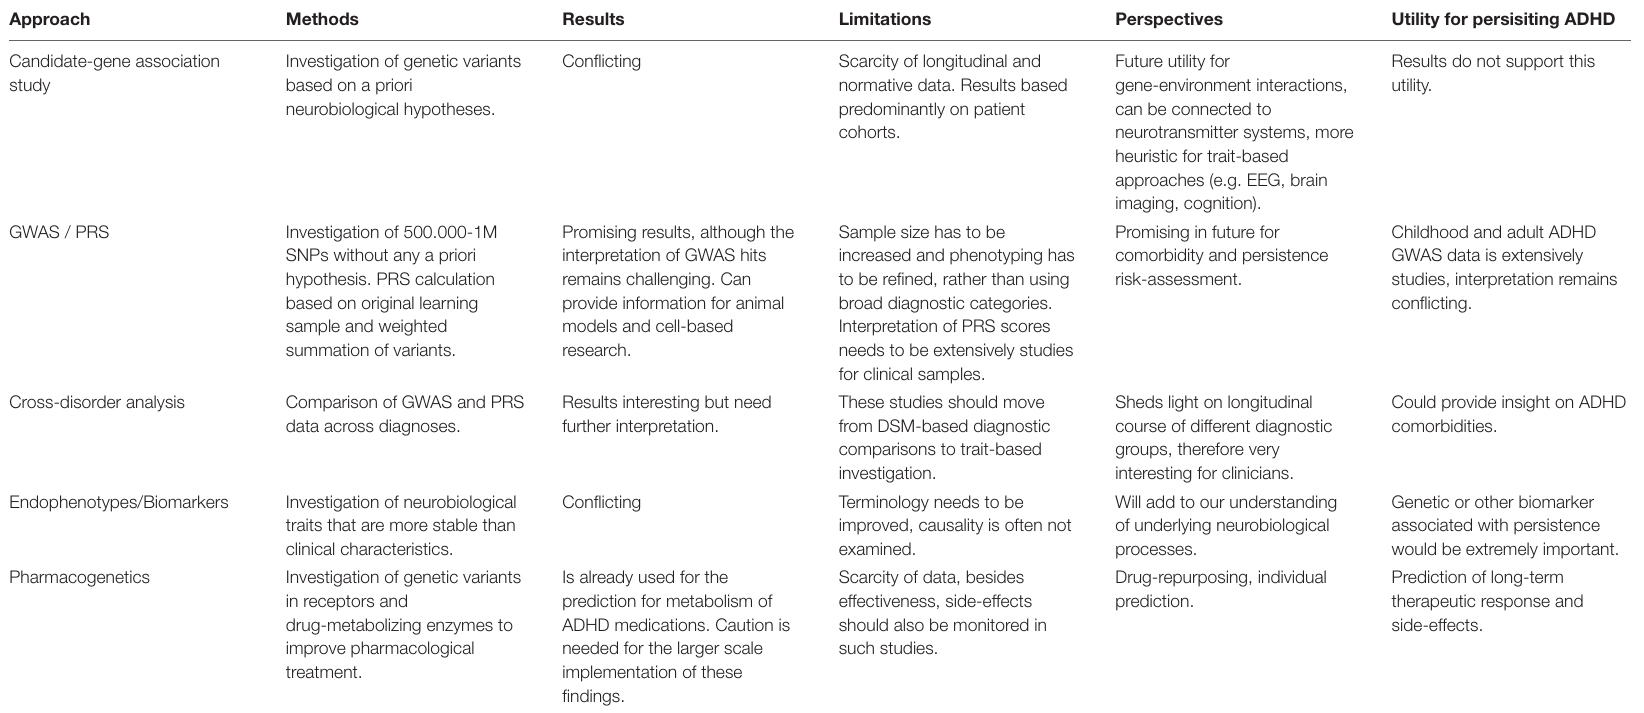
TABLE 3 | Summary of potential approaches bridging ADHD genetic research and clinical